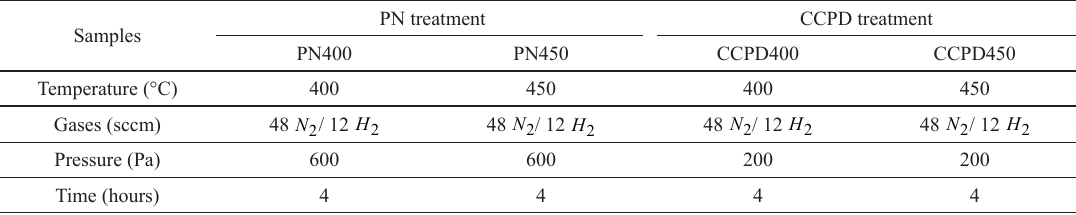
Table 1. Plasma nitriding treatment parameters.